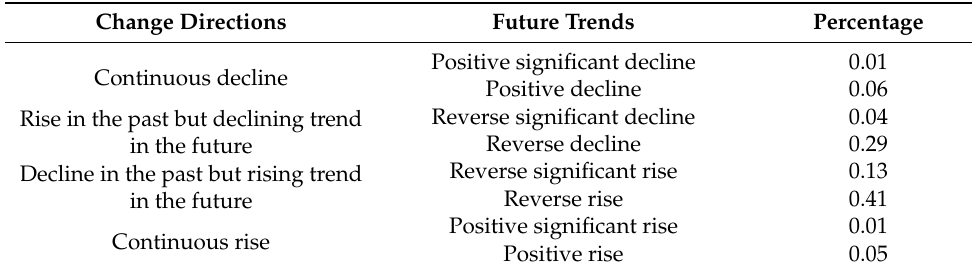
Figure 10. Hurst distribution map and CS future trend map. Table 5. The percentage of different future change trends in